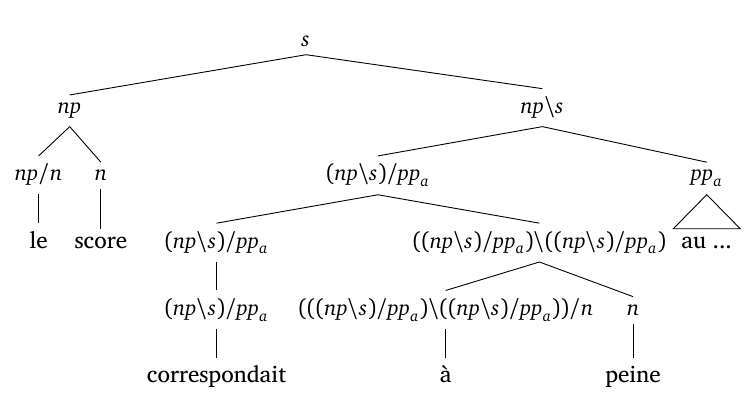
First derivation corresponding to Figure 3, using only elimination